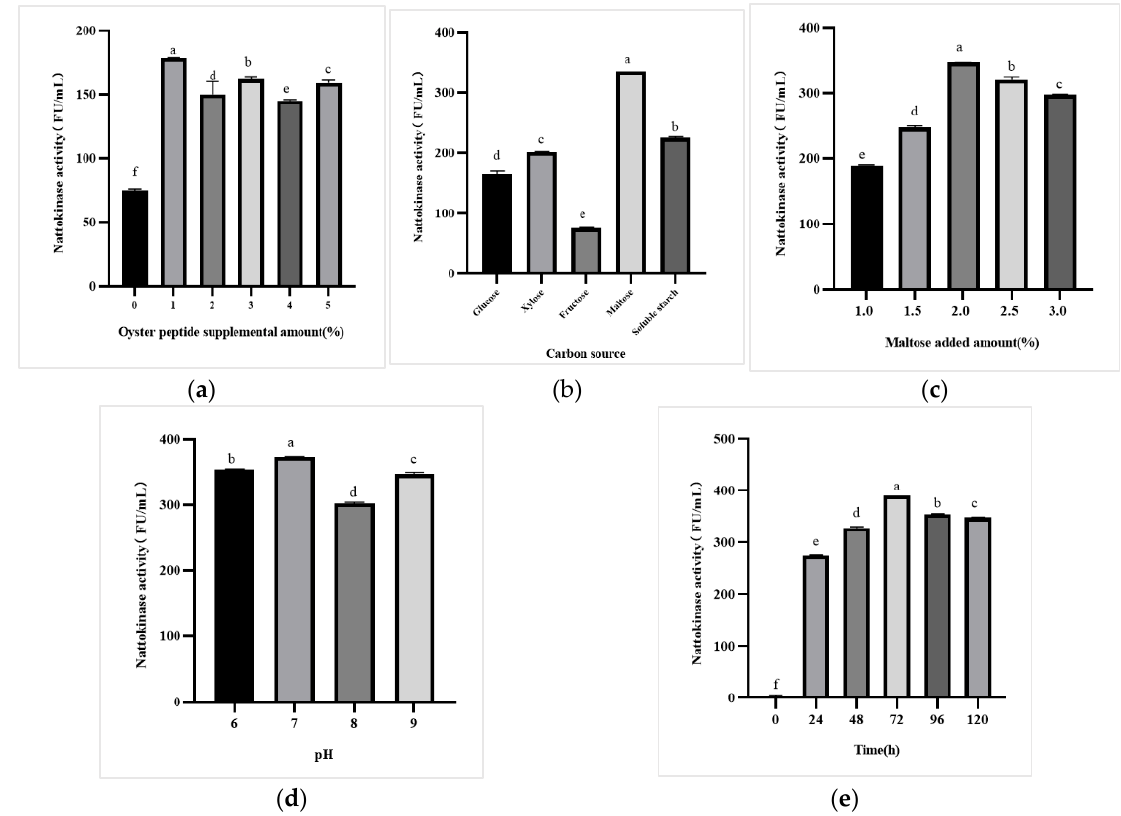
Figure 2. Effects of fermentation conditions on the production of nattokinase. ( a ) Nattokinase activity of PSP2 in media with different oyster protein hydrolysate additions. ( b ) Nattokinase activity of PSP2 in media with different carbon sources. ( c ) Nattokinase activity of PSP2 in media with different maltose additions. ( d ) Nattokinase activity of PSP2 in media with different initial pH. ( e ) Effect of fermentation time on the production of nattokinase by PSP2 ( p < 0.05). Different lowercase letters in the figure indicate significant differences between values. Table 1. Changes of total sugar, total protein, and amino acid contents in oyster fermentation